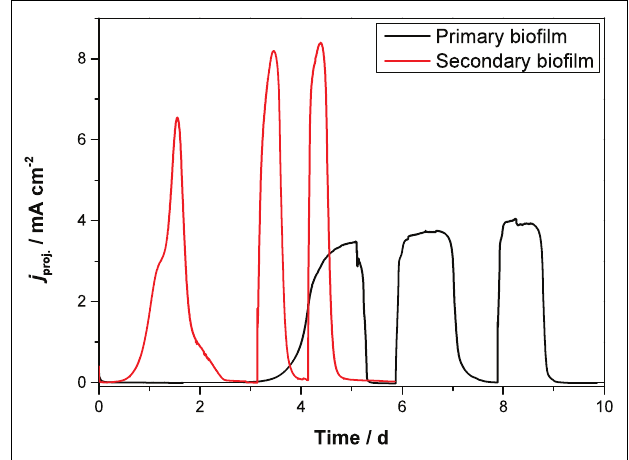
FIGURE 3 | Current generation of a primary (black) and a secondary (red) biofilm at LCC electrodes during the first three semibatches after inoculation .The applied potential was 0.2V, the temperature was 35°C.